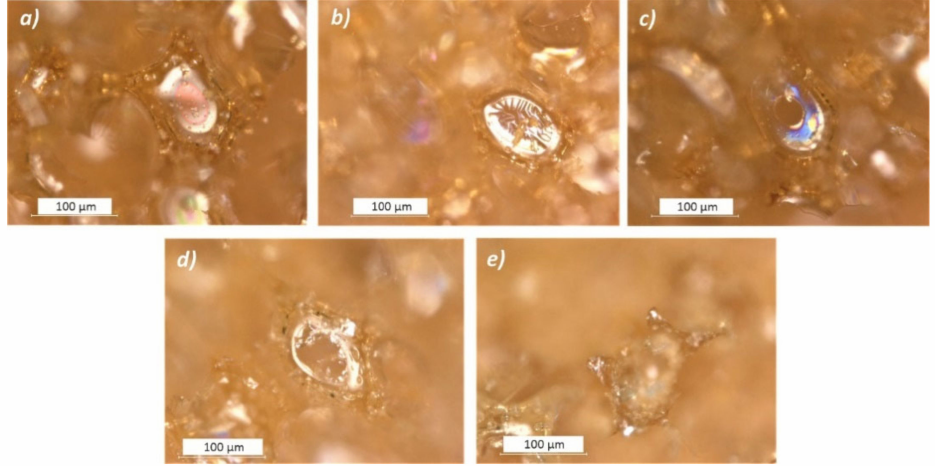
Figure 5. Proposed phases of the cell-rupture mechanism observed by a digital microscope with reflected light: ( a ) bubbles increase and get bigger; ( b ) a circular mark appears on the thin layer of the cell; ( c ) a hole is formed; ( d ) the layer breaks; and ( e ) cell walls become thinner and